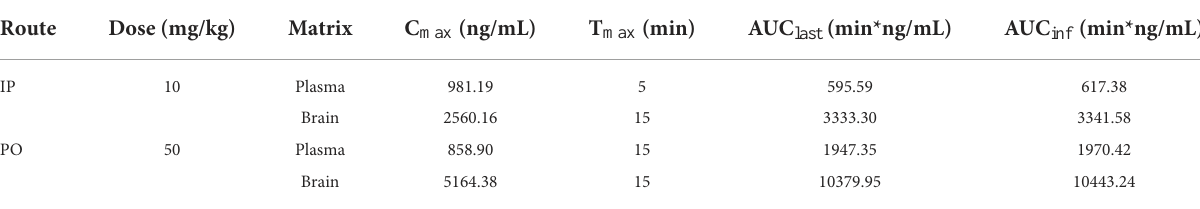
TABLE 1 Pharmacokinetic (PK) parameters for FD44